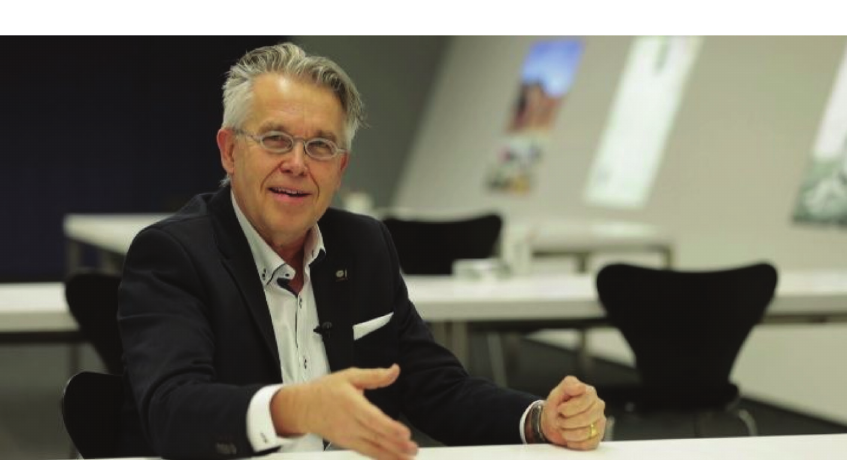
Fig. 2: Heinz Hieke explains why he enthusiastically improves metadata of photographs (Screenshot retrieved June 15, 2019, from